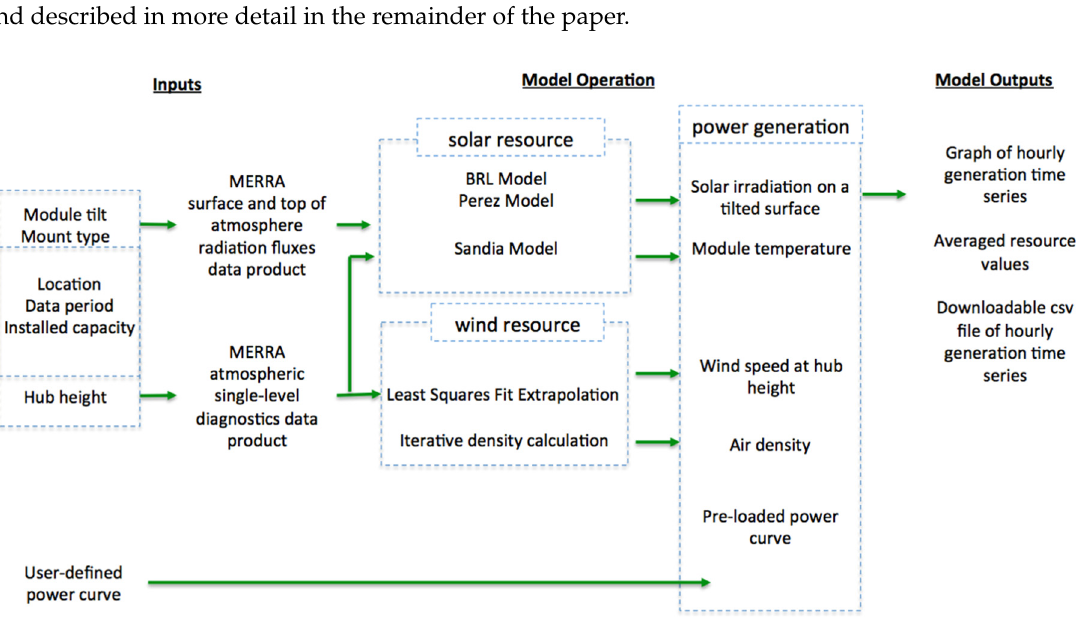
Figure 1. Workflow of the model process.